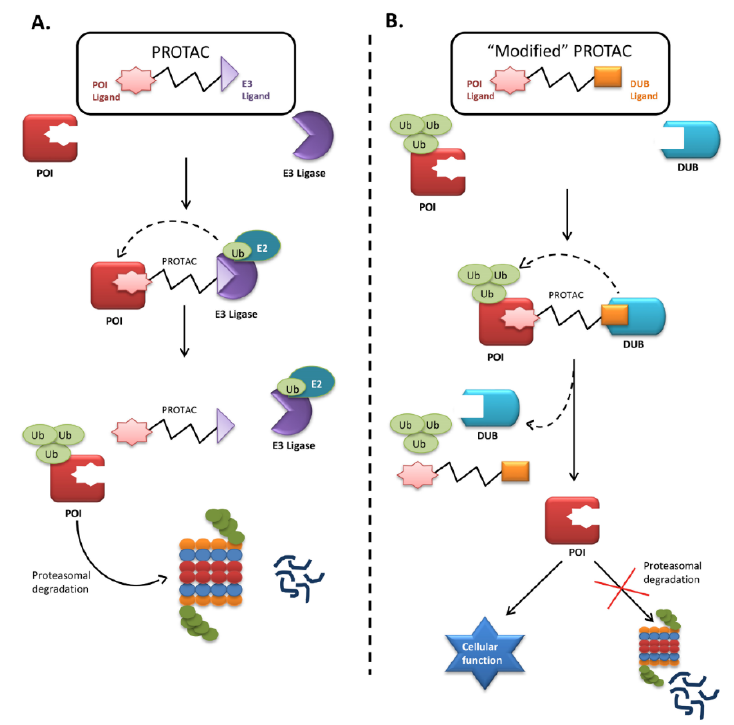
Figure 2. Mechanism of proteolysis-targeting chimera (PROTAC) and “Modified” PROTAC. ( A ) Proteolysis-targeting chimaera (PROTAC) are bifunctional molecules, whose one end binds to the protein of interest (POI) while the other recruits E3 ligase forming a ternary complex. The E3 ligase induces proximity-induced ubiquitination of POI by transferring the ubiquitin (Ub) molecules from E2 enzyme to the POI, thus facilitating its degradation; ( B ) Representation of a hypothetical figure where technology can be modified to rescue the functional misfolded proteins undergoing rapid degradation in inherited metabolic disorders like PKU and HT1 having partial functions, causing deficiency of available protein for cellular functions. Hence, a PROTAC can be designed whose one end binds to the misfolded POI and the other binds to a ligand that can recruit the regulatory DUB. The DUBs will cleave off the ubiquitin molecule, avoiding the protein degradation, and will help to maintain a pool of protein required for normal cellular function.